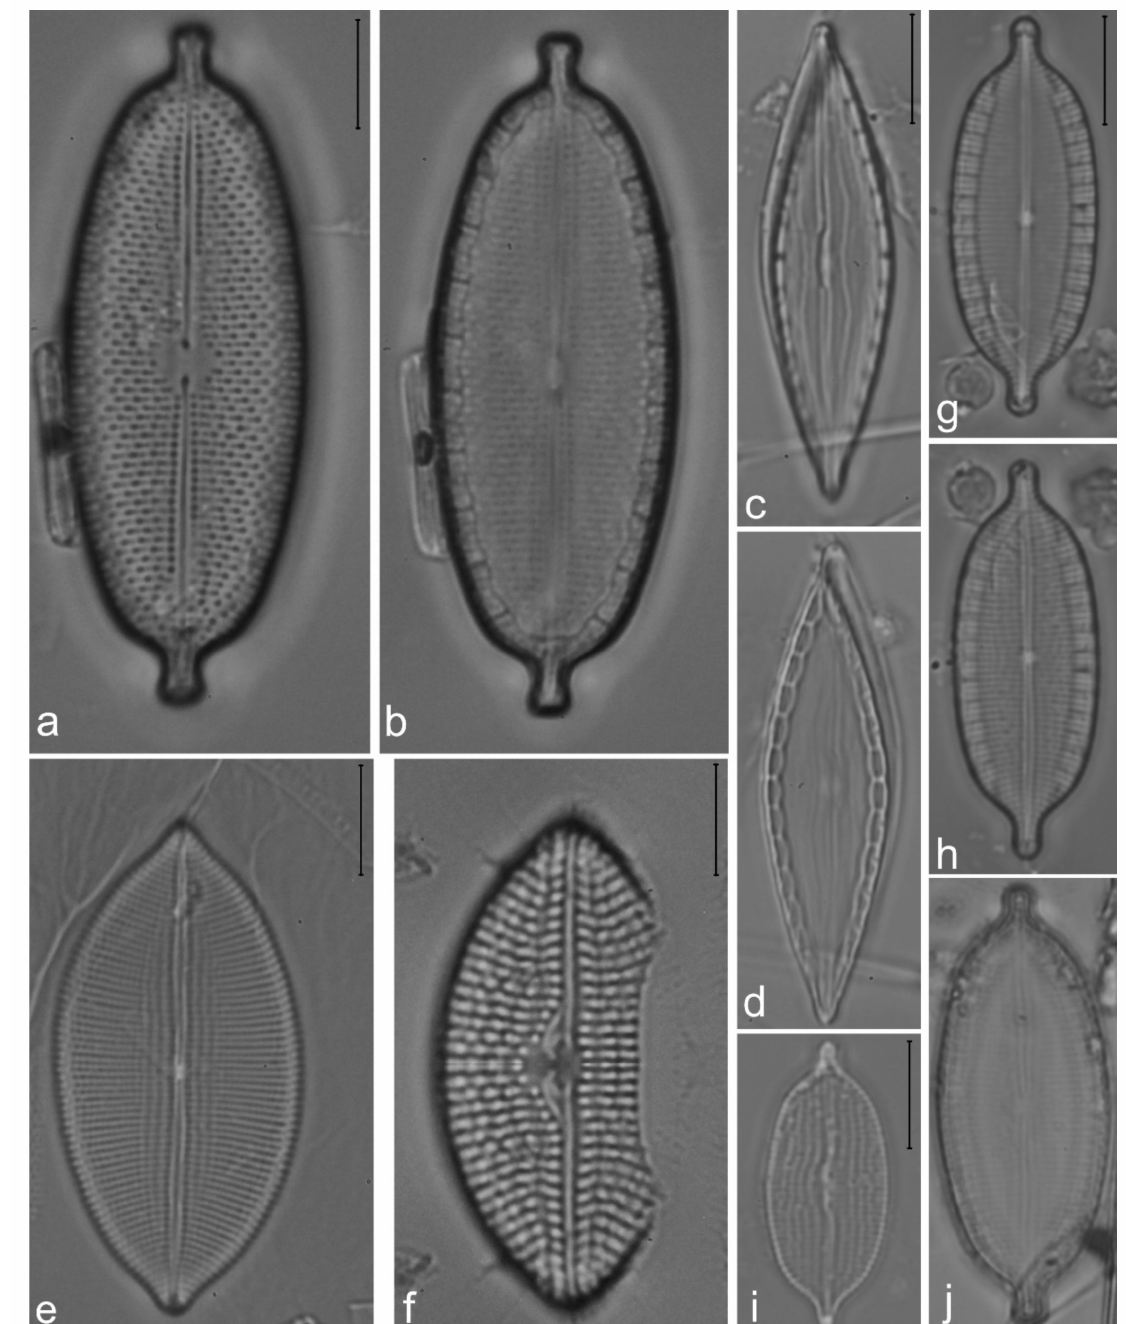
Figure 23. ( a , b , j ) Mastogloia stephensiana ; ( c , d ) M . borneensis ; ( e ) M . mauritiana var. mauritiana ; ( f ) M . bahamensis ; ( g , h ) M . ignorata ; ( i ) M . parva . Scale bar = 10 µ